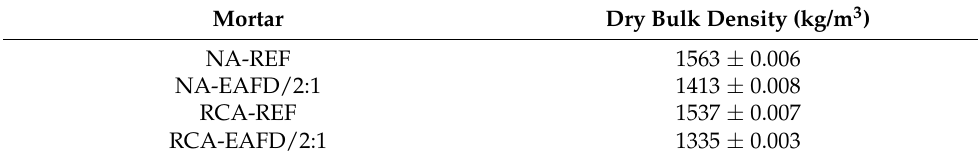
Table 6. Dry bulk density of the hardened mortar: mean values and standard deviation.